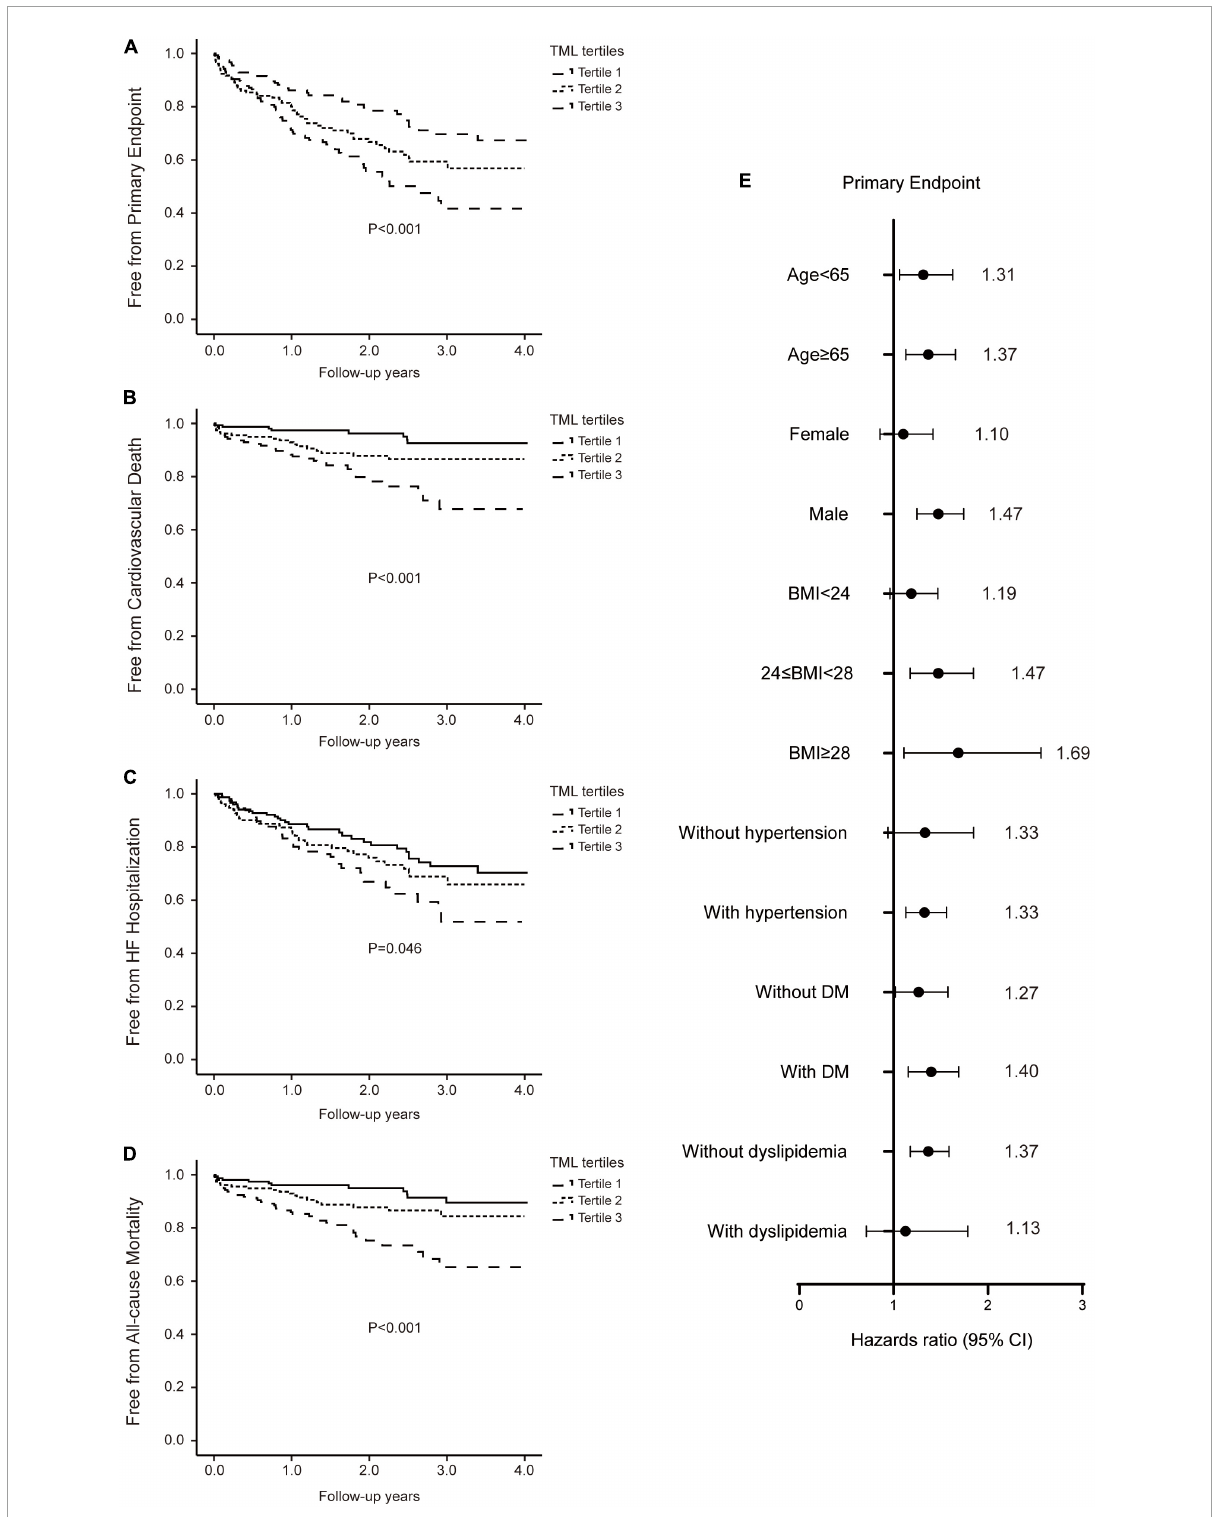
FIGURE3 Increased trimethyllysine (TML) levels are associated with poor prognosis in patients with heart failure (HF). Kaplan–Meier curves and log-rank analyses illustrating the risks of the primary endpoint (A) , cardiovascular (CV) death (B) , hospitalization due to HF (C) , and all-cause mortality (D) , stratified by the tertiles of TML levels in patients with HF. (E) Forest plots indicating the risks of the primary endpoint in different subgroups according to TML levels in patients with HF. Symbols represent hazard ratios (HRs) and line length indicates the 95% confidence